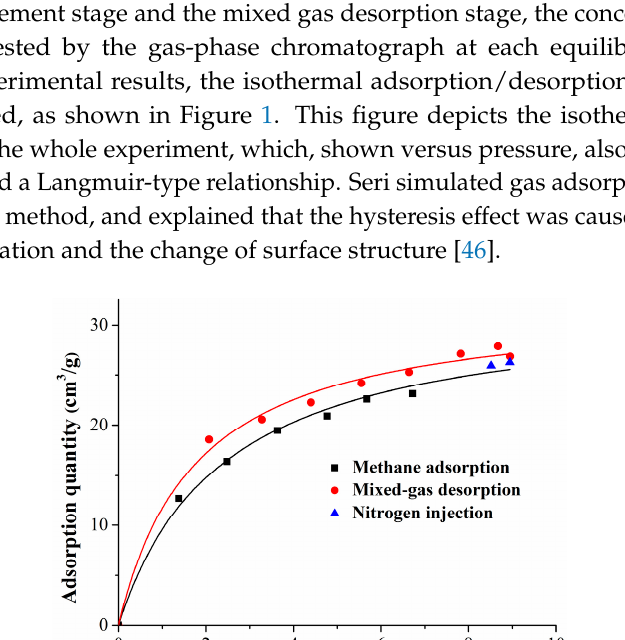
Table 1. Gas adsorption constant, density, and modulus of elasticity of coal samples.